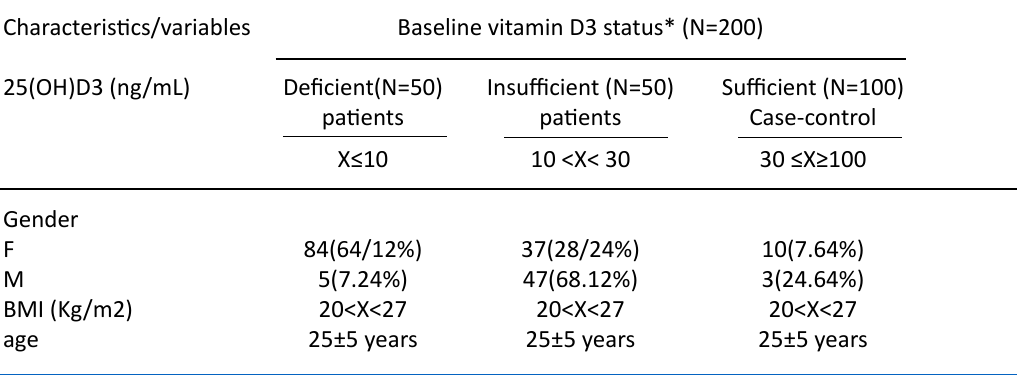
Table 1. Demographic and serum vitamin D3 variables in participant